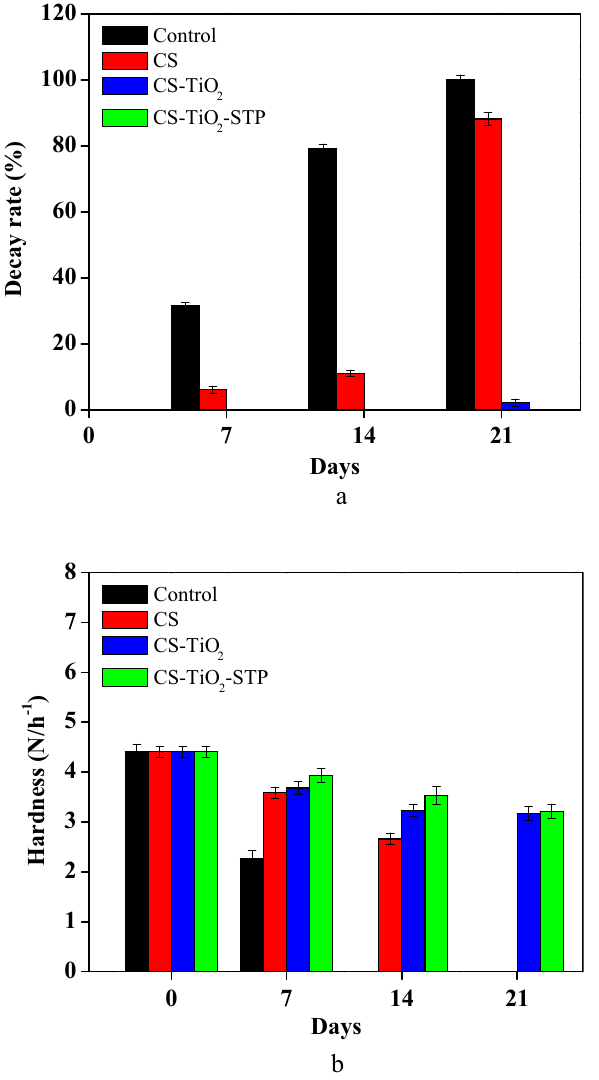
Figure 1. Effect of coating treatments of cucumber samples on decay rate ( a ), and hardness ( b ); (Control) refers to the treatment with distilled water, CS is the (Chitosan), CS-TiO 2 is Chitosan/Titanium Dioxide Nanoparticles, while CS-TiO 2 -STP is (Chitosan/Titanium Dioxide Nanoparticles/Sodium